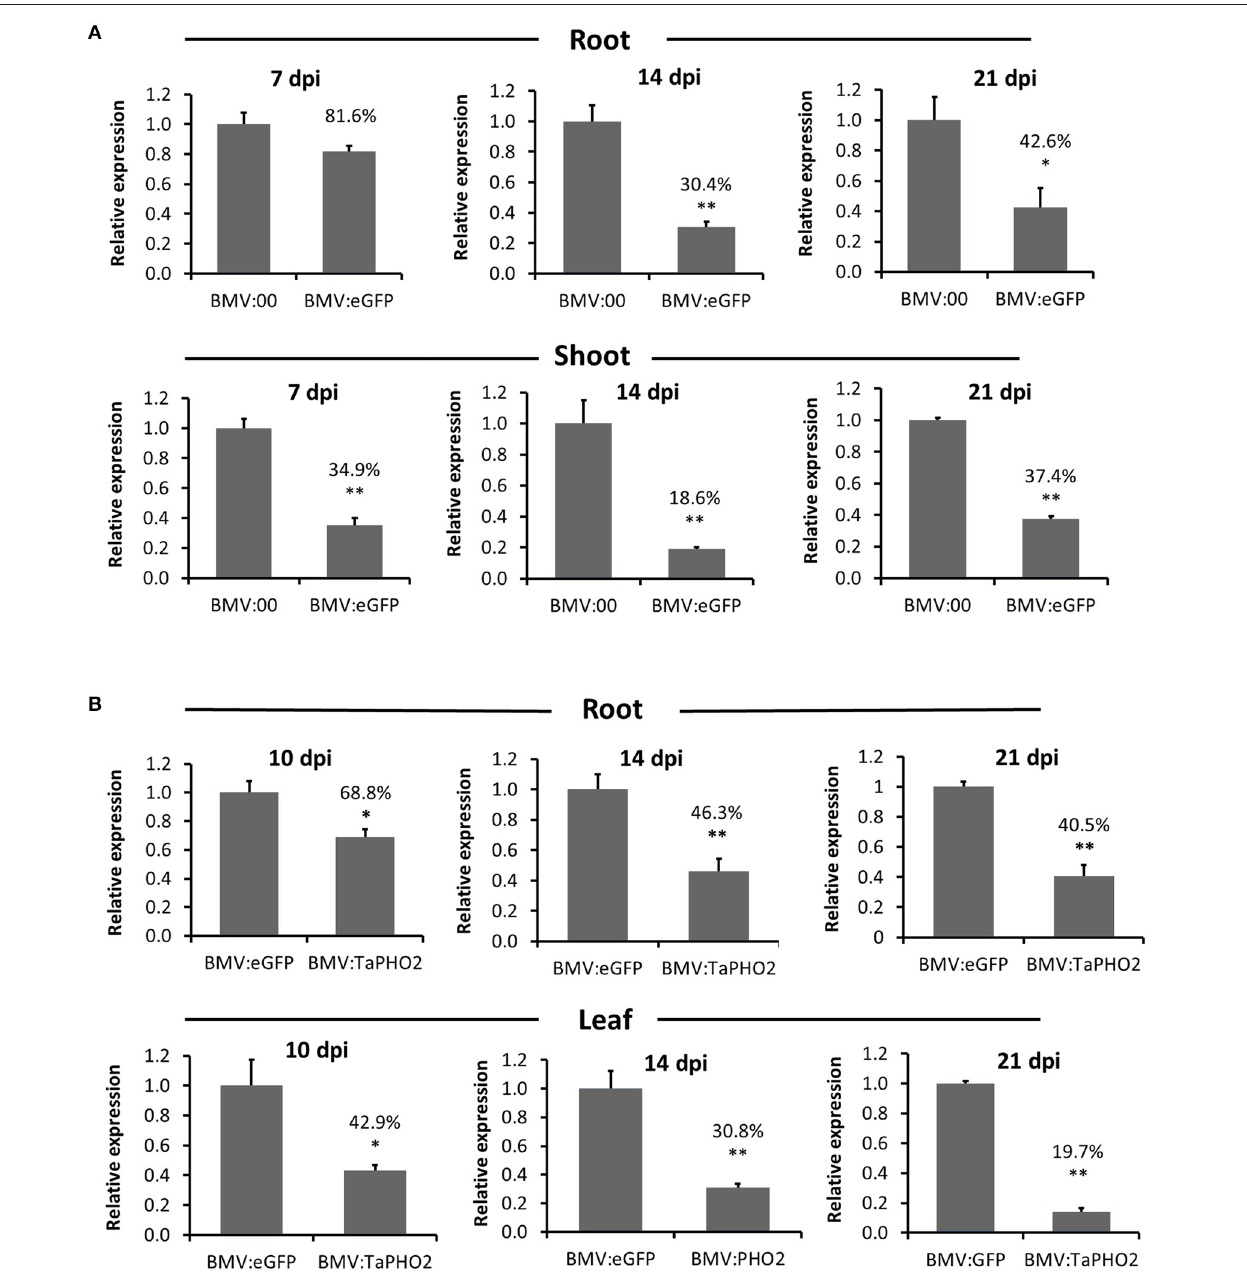
FIGURE 5 | Comparison over time of BMVCP5-mediated silencing of eGFP and TaPHO2 in wheat root and aerial tissues. (A) Relative expression levels of eGFP mRNA in roots and shoots from transgenic OsRCg2GFP wheat ( cv . Fielder) plants infected with BMV:eGFP (180-nt insert) or BMV:00 (no insert control) at 7, 14, and 21 dpi. Percentage values are relative to the BMV:00 control. Values represent means + SE of four to seven biological replicates, and treatment values compared ( t -test: * P < 0.05; ** P < 0.01). (B) Relative expression levels of TaPHO2 mRNA in roots and leaves from wheat plants ( cv . Overley) inoculated with BMV:TaPHO2 (114-nt insert) or BMV:eGFP (107-nt insert) at 10, 14, and 21 dpi. Target gene mRNA levels were analyzed by RT-qPCR, and values normalized against relative TaEF1 α mRNA levels. Percentage values are relative to the BMV:eGFP (107-nt insert) control. Values represent means + SE from three to six biological replicates, and treatment values compared ( t test; * P < 0.05; ** P < 0.01). Similar results were obtained in two independent